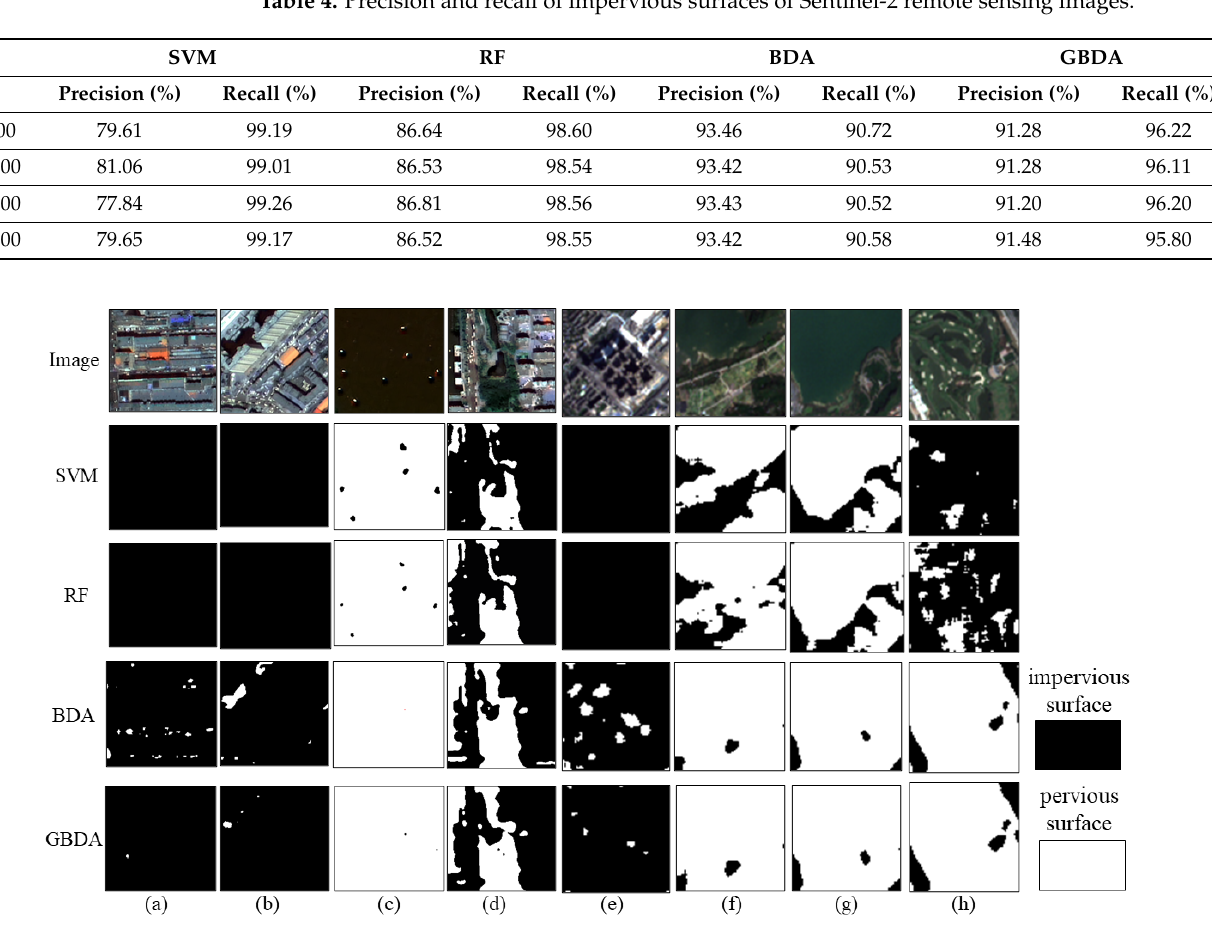
Figure 13. Local view of GF-2 and Sentinel-2: ( a ) GF-2 shaded 1; ( b ) GF-2 shaded 2; ( c ) GF-2 water surface; ( d ) GF-2 woodland and water; ( e ) Sentinel-2 shading; ( f ) Sentinel-2 bare soil; ( g ) Sentinel-2 water surface 1; ( h ) Sentinel-2 water surface 2.